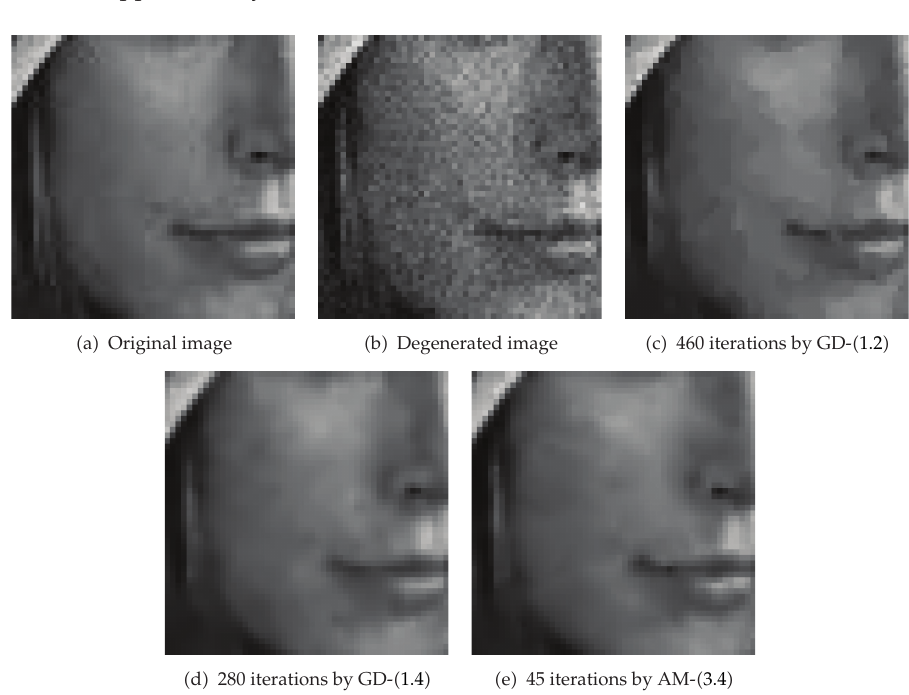
Figure 2: Enlarged partial recovered results by di ff erent approaches.